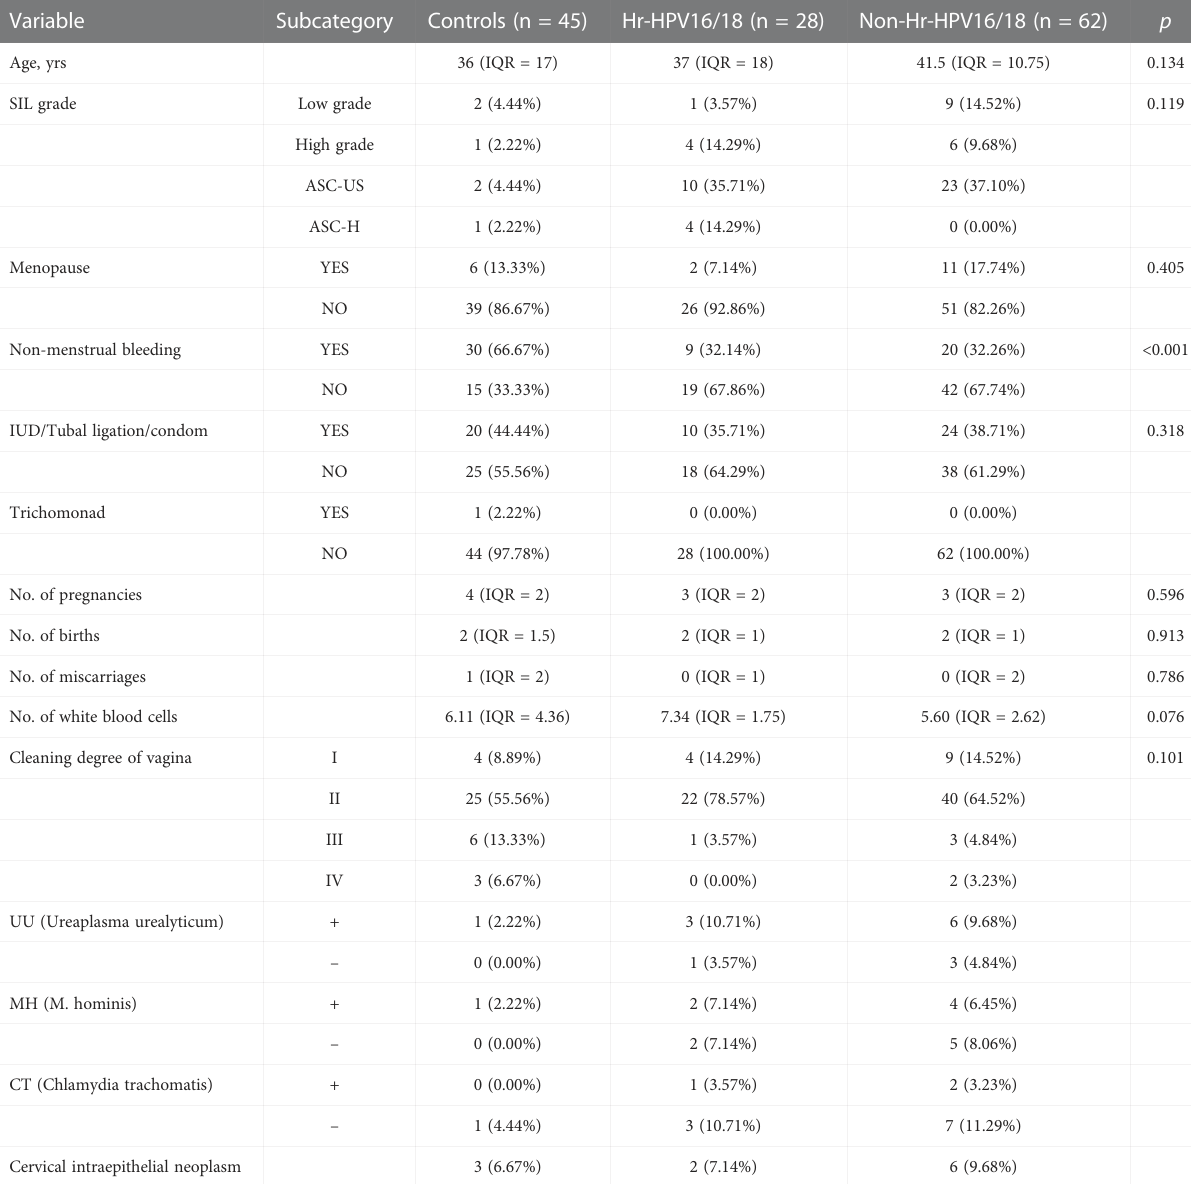
TABLE 1 Descriptive characteristics of all samples included in the